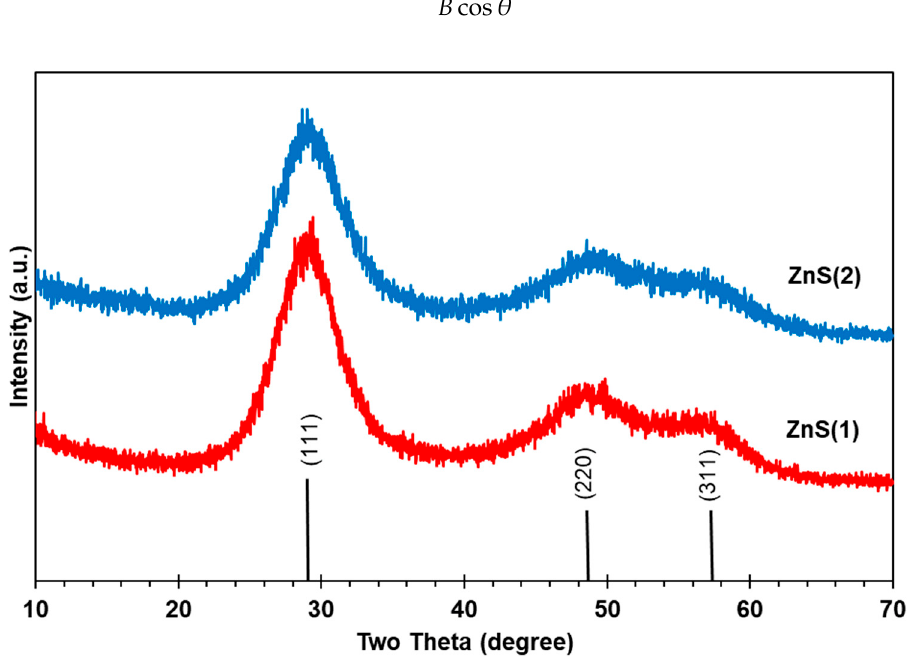
Figure 2. X-ray diffraction (XRD) patterns of samples ZnS(1) and ZnS(2). Figure 2. X-ray di ff raction (XRD) patterns of samples ZnS(1) and